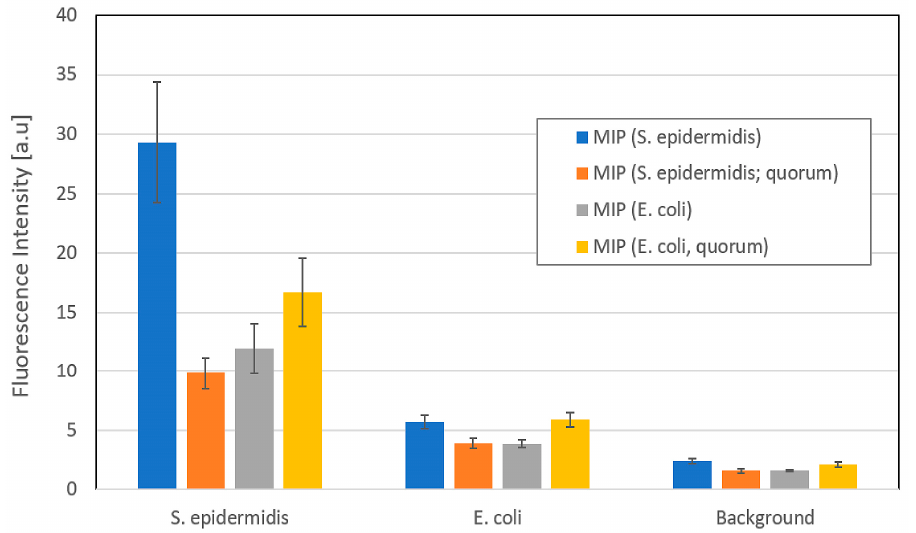
Figure 10. Fluorescence intensities obtained from exposing different bacteria strains to four different MIP. Intensities result from averaging the mean gray values of five areas of each combination of surface and MIP, respectively.